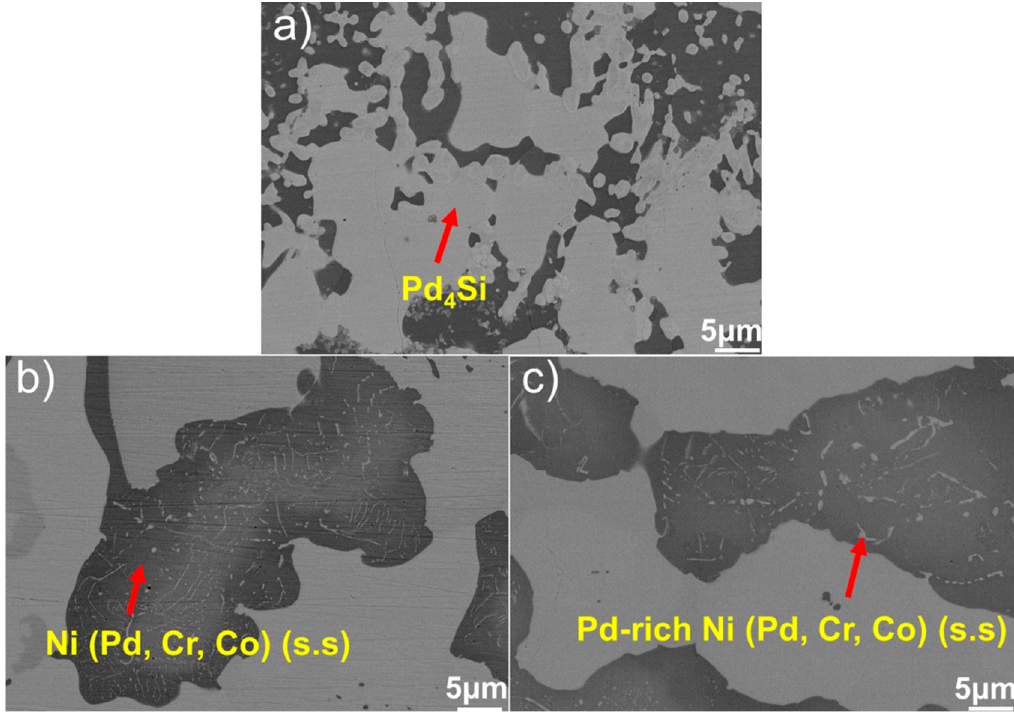
Figure 4. SEM back-scattered electron images of the zone 1 in the DD98M/Pd-Si/DD98M joints brazed at different temperatures for 30 min: ( a ) 1020 ° C, ( b ) 1060 ° C, and ( c ) 1100 ° C.